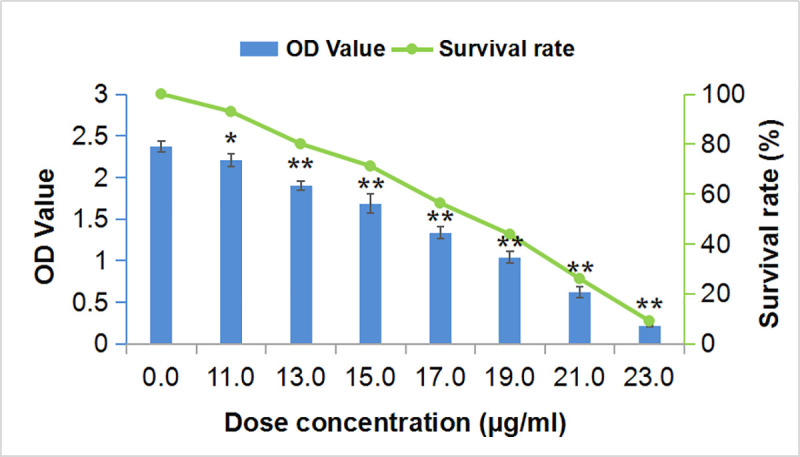
OD values and survival rates of A549 cells at different concentrations of SSE.(* p < 0.05, ** p < 0.01 compared with the concentration of 0 mg/mL).